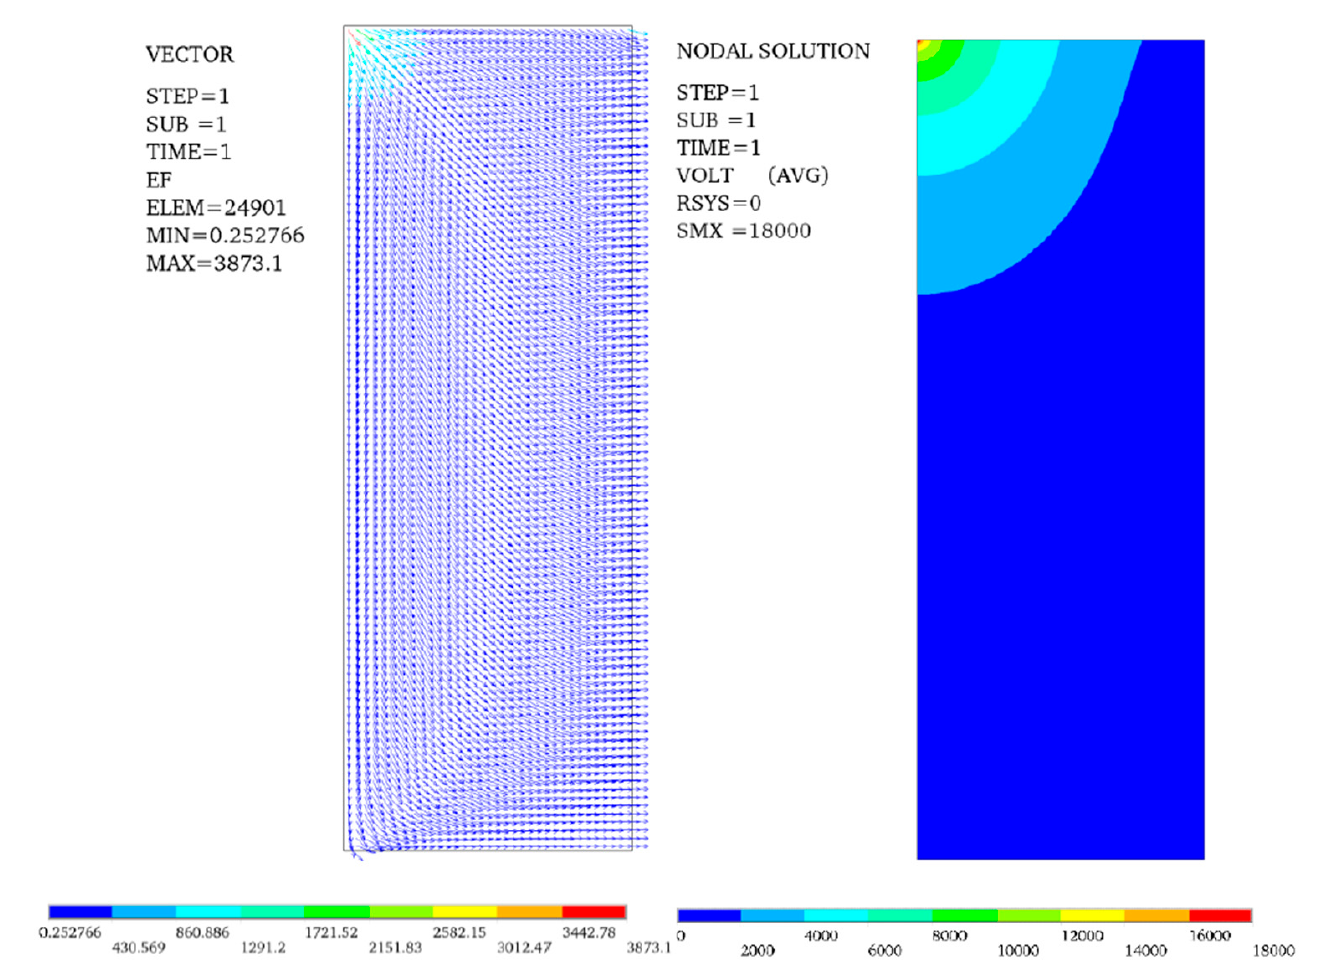
Figure 3. Results of FEM calculated model of electric field strength vector field ( left ) and electric potential ( right ) in EHD generator geometry.